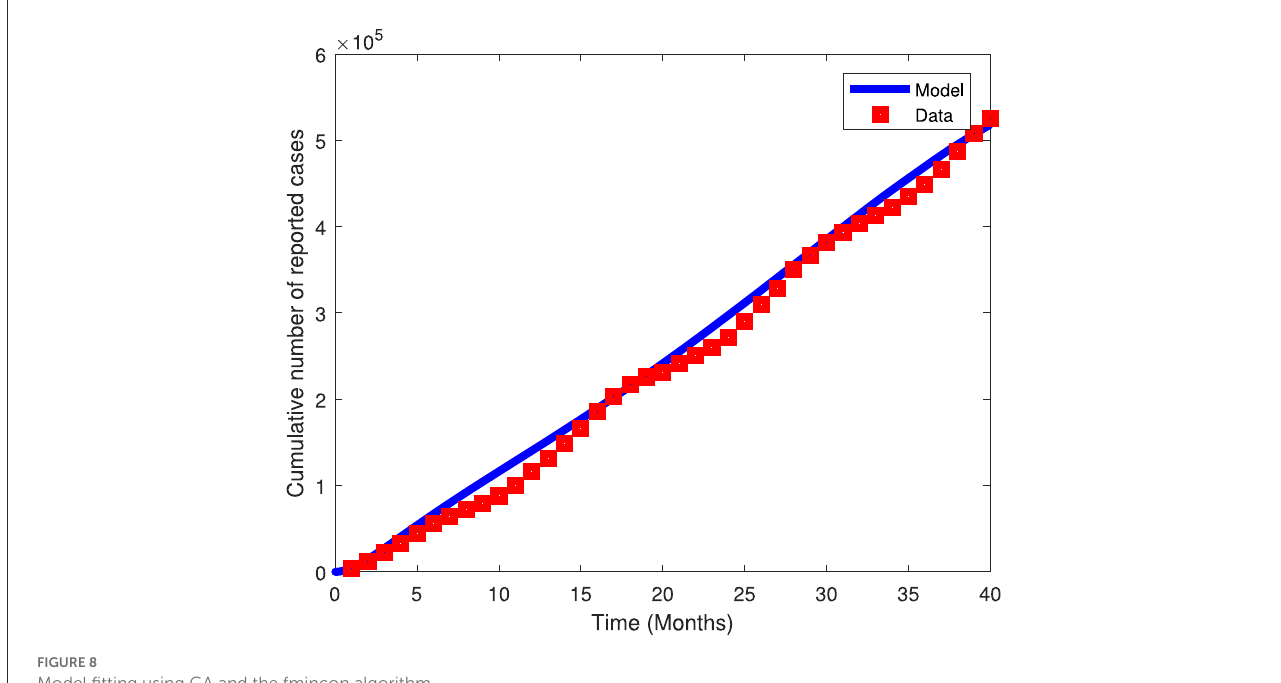
FIGURE8 Model fitting using GA and the fmincon algorithm.